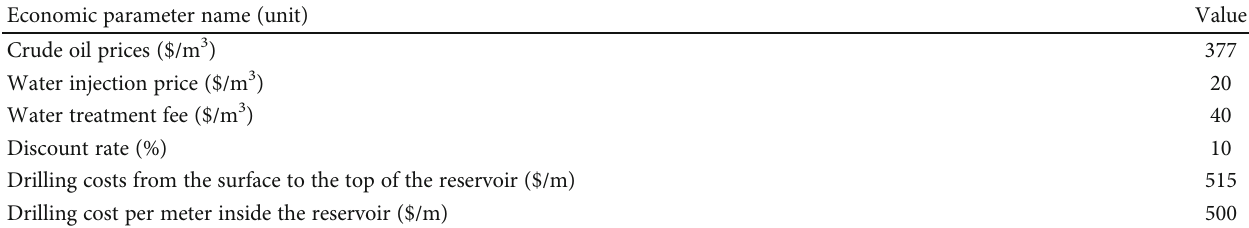
Table 1: Net present value parameter values.